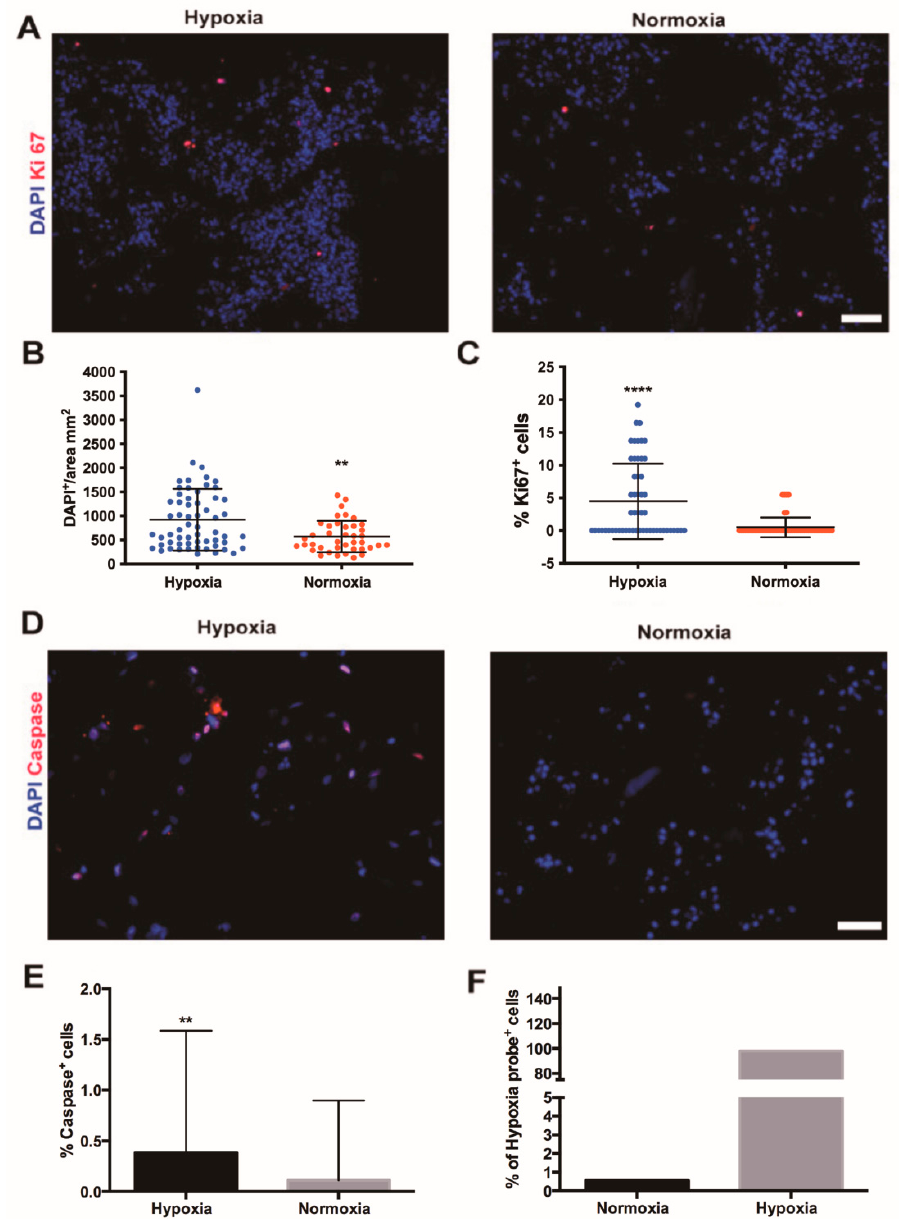
Figure 2. Effects of perfusion culture under hypoxia or normoxia on human stromal vascular fraction cell proliferation and apoptosis. ( A ) Immunofluorescence staining for Ki67, the marker of proliferation (red) of perfused SVF cell-based constructs in either hypoxia or in vitro normoxia. Cell nuclei were stained with DAPI (blue). Scale bar = 70 µ m. Quantification of total number of SVF cells (DAPI-positive cells) ( B ) and percentage of proliferating (Ki67-positive) cells ( C ) in constructs cultured in perfusion culture under high or low oxygen tension. **** p < 0.00001; ** p < 0.001. n = 72 (6 donors). ( D ) Immunofluorescence staining for marker of apoptosis (cleaved caspase-3, red) of SVF cell-based constructs cultured in hypoxia and in vitro normoxia. Cell nuclei were stained with DAPI (blue). Scale bar = 35 µ m. ( E ) Percentage of apoptotic cells, positive for cleaved caspase-3 in constructs cultured in perfusion culture under high or low oxygen tension. ** p < 0.001. n = 36 (3 donors). ( F ) Flow cytometry analysis of SVF cells cultured in perfusion in normoxia or hypoxia positive to the pimonidazole. Donor n = 1. Comparison was performed with non-parametric test (Mann–Whit ‐ ney ‐ U).